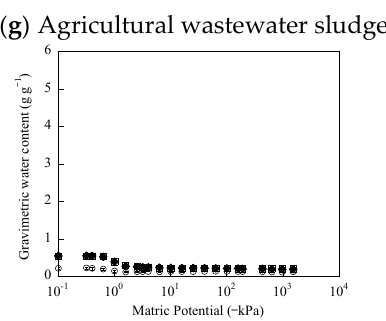
Figure 4. Water retention curves (WRCs) of biochar samples. ( a ) Japanese cedar (CE); ( b ) Japanese cypress (CY); ( c ) moso bamboo (MB); ( d ) rice husk (RH); ( e ) sugarcane bagasse (SB); ( f ) poultry manure (PM); ( g ) agricultural wastewater sludge (WS). Table 3. Available water capacity (AWC) estimated from water retention curves (WRC) of biochar samples.